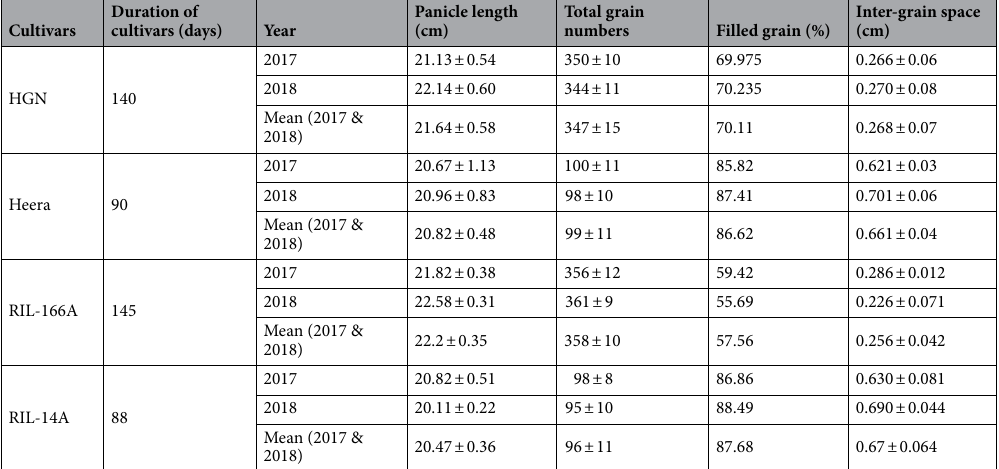
Table 1. Morphological feature of panicles of parental cultivars and two RILs selected based on high spikelet number (compact) and low grain number (lax) panicle and their fertility percentage. Inter-grain space = Total length of primary branch / total number of spikelets per panicle. All values are mean of five replicates.